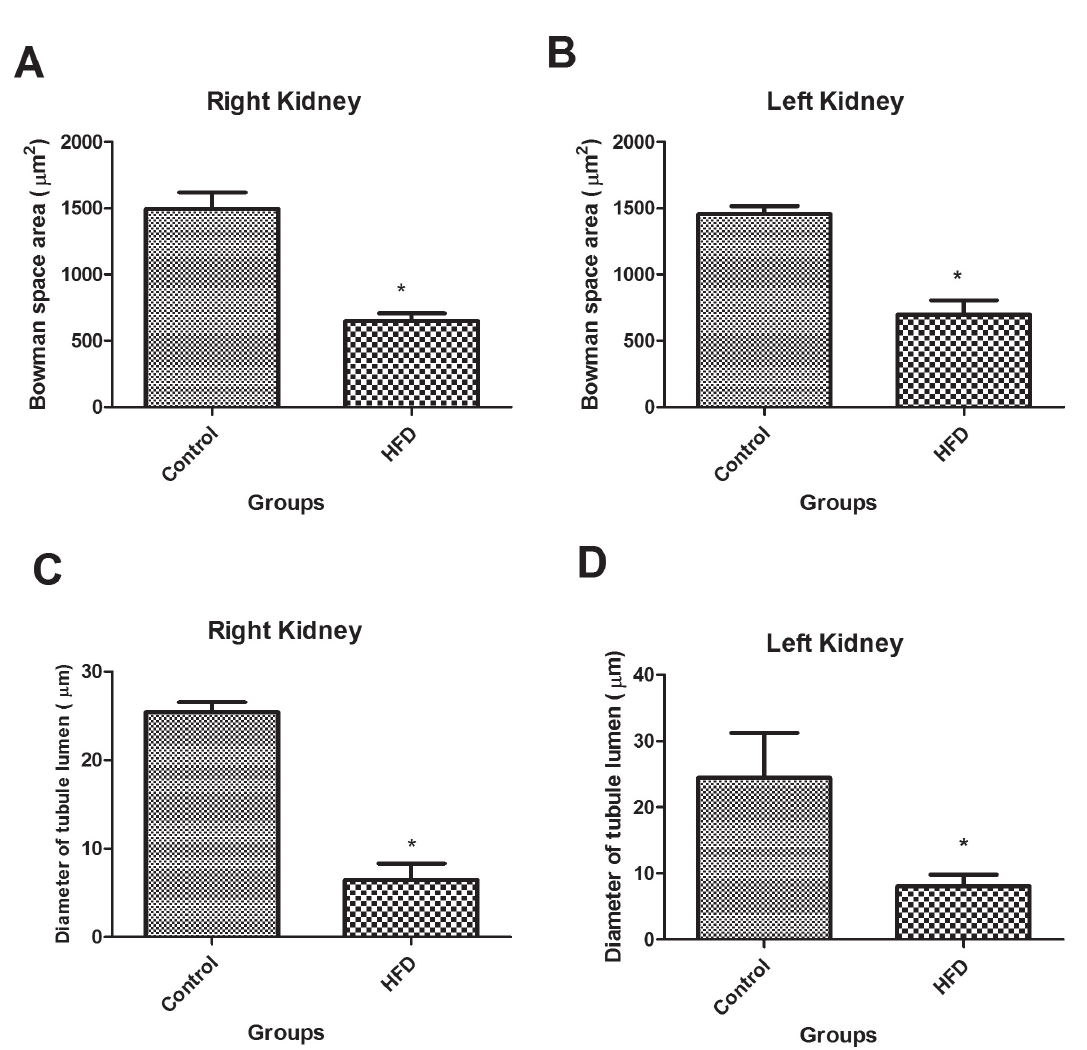
FIGURE 3 - Morphometric renal analyzes. The Bowman space area (A) and the diameter of tubule lumen (B) was measured. * represent p<0.05 of t test (n=6). TABLE III - Biochemical serum/plasma analysis of mice fed control or high-fat